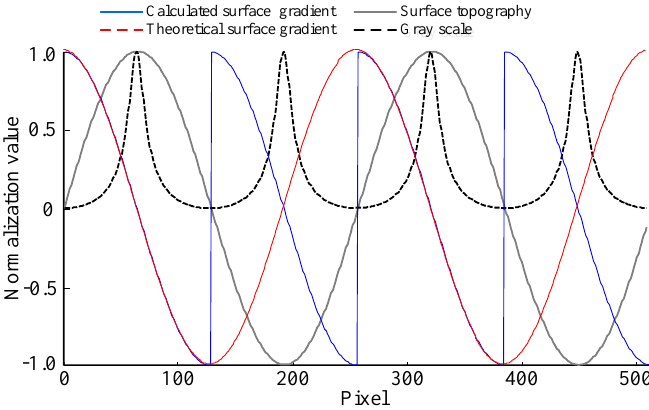
Figure 6. The relationship between surface topography, surface gradient, and gray scale.